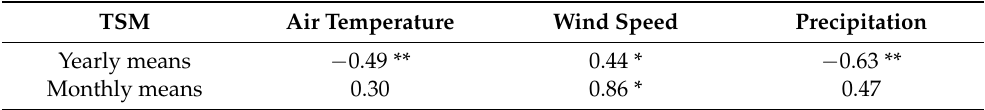
Figure 7. The monthly mean values of TSM across Lake Qinghai from 1986 to 2020. Table 5. The correlation coefficients between temperature wind speed precipitation and TSM in terms of yearly and monthly